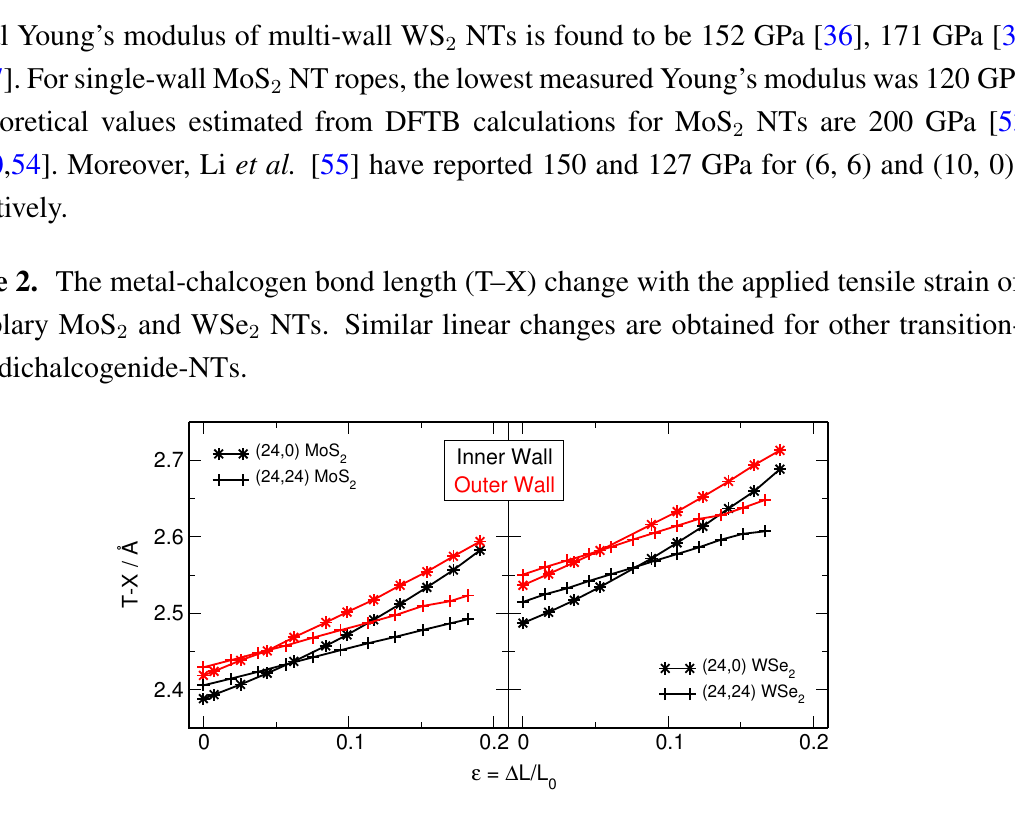
Figure 3. The calculated strain-stress relation of TX the tube axis. Note the different scale on x - and y -axes of TTe